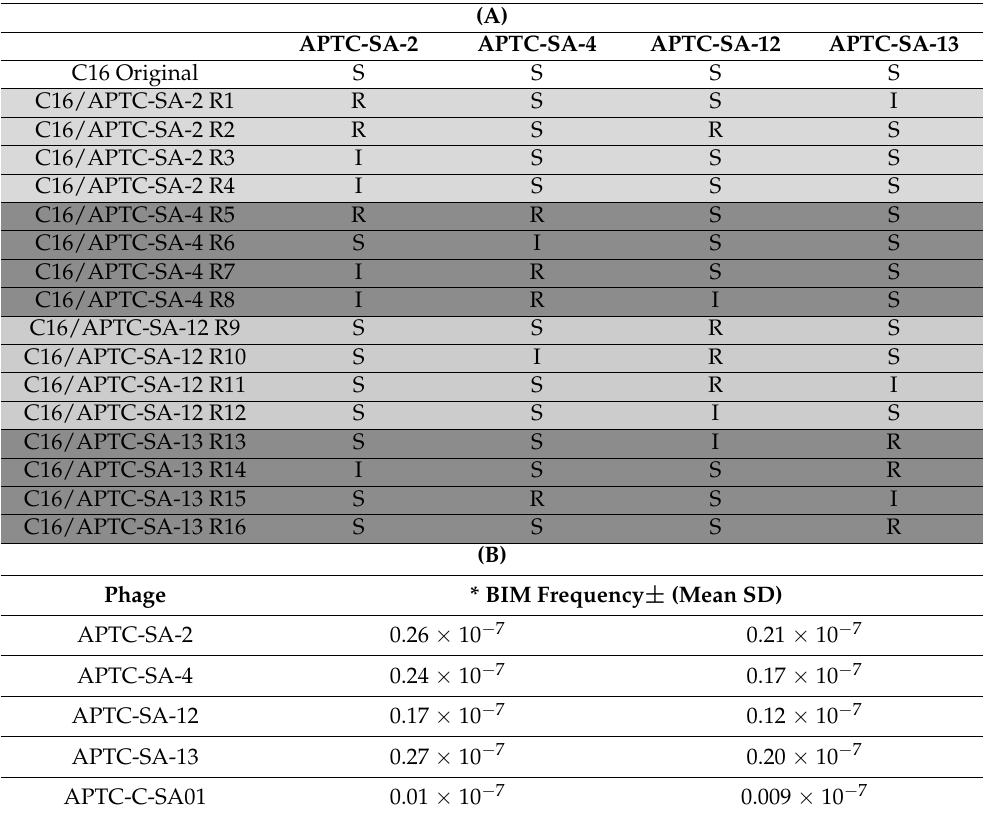
* Experiment performed using manufacturing strain C16. The average of three independent experiments is shown.